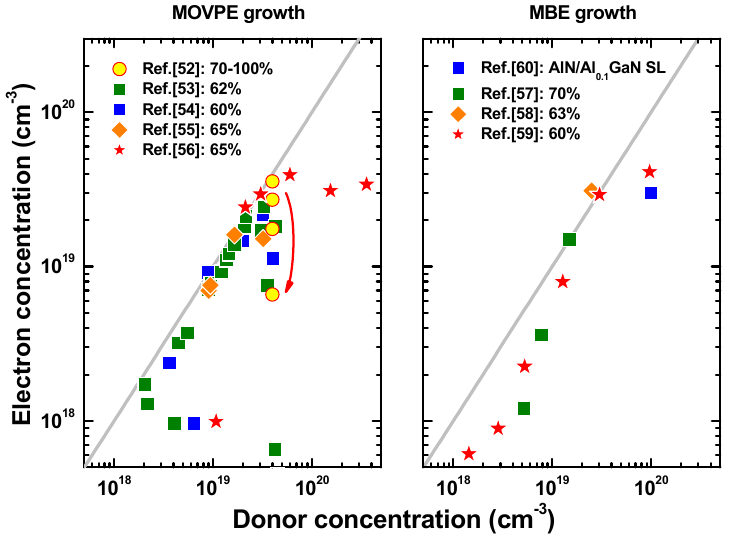
Figure 3. Electron concentration vs. Si-donor concentration in n + -AlGaN alloys grown by MOVPE ( left ) and MBE ( right ) techniques. Symbols are data from various sources (see text). Grey solid lines correspond to equal electron and donor concentrations. The arrow in the left plot indicates the decrease of the electron concentration with the AlN molar fraction reported by Nakarmi et al. [52]. Inset legends on both plots indicate the percentage of Al in the AlGaN alloys.